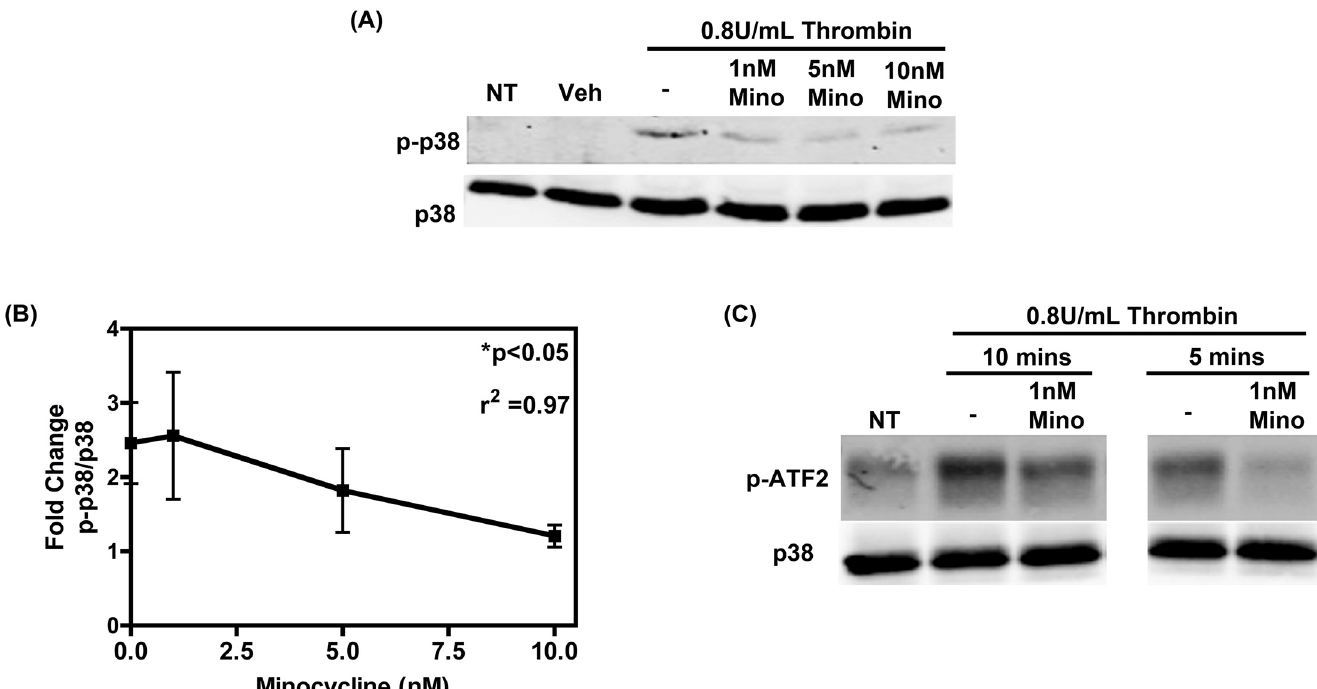
Fig 7. Minocycline reduces phosphorylation of MLK3 and p38 MAPK in platelets. (A) Isolated, washed human platelets were subjected to 5-minute thrombin treatment with or without increasing concentrations of minocycline pre-treatment, as indicated. Whole cell lysates were subjected to immunoblot analysis using phosphorylated p38 MAPK or total p38 MAPK-specific antibodies. Data shown is representative of a single experiment that was repeated three times. (B) Densitometric quantification of the immunoblot from (A) negatively correlates with increasing minocycline concentration. Data was compared using Pearson ’ s correlation statistical test with r 2 = 0.97. (C) Platelets were treated with thrombin for 10 or 5 minutes with or without minocycline pretreatment and whole cell lysates were subsequently collected. Activity of p38 MAPK was measured via a p38 in vitro kinase assay using ATF-2 as a substrate, following the indicated treatments. Data shown is representative of three separate